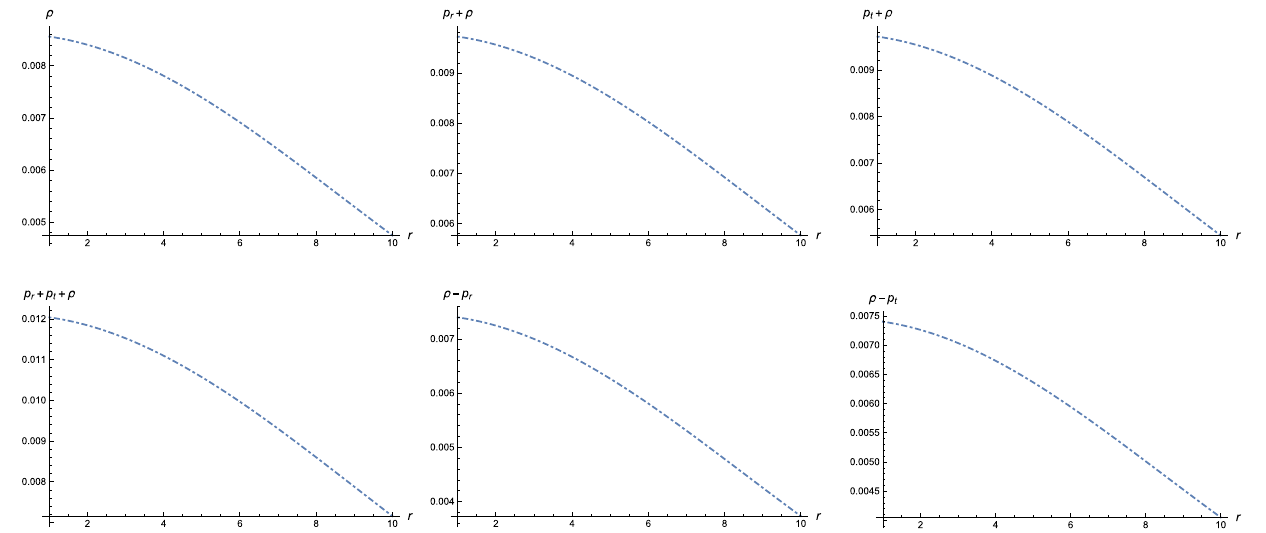
Fig. 6 Plots of energy conditions with respect to radius r (km) of the strange star candidate Her X-1